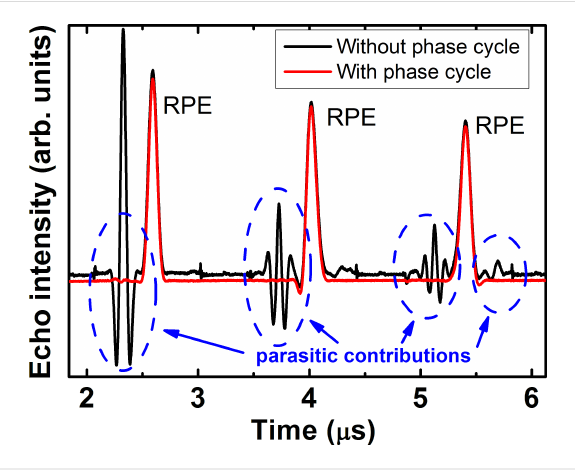
Figure 9: CPMG experiment on complex P1 at ν = 33.9 GHz, T = 20 K, and H || z -axis: Separation of the refocused primary echoes (RPE) from other parasitic contributions by applying the modified CPMG pulse ( π /2) x – τ 1 – ( π ) y – τ 1 – echo – { τ 2 – ( π ) y – τ 2 – echo} ( n − 1) with τ 1 = 400 ns and τ 2 = 700 ns (black line). The signal plotted in red is the result of the phase cycling of the first π pulse that effectively suppresses the “parasitic” contributions to the true CPMG echoes (see the